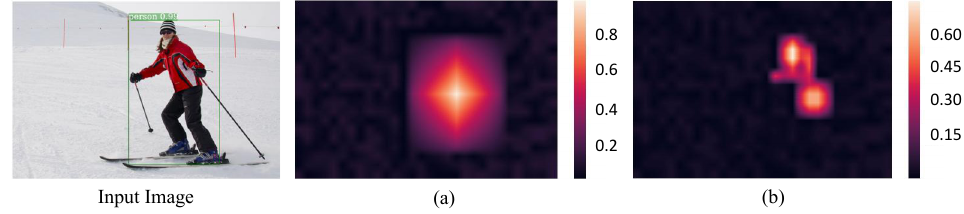
Figure 1. The visualization of weight assignment results for FCOS ( a ) and our algorithm ( b